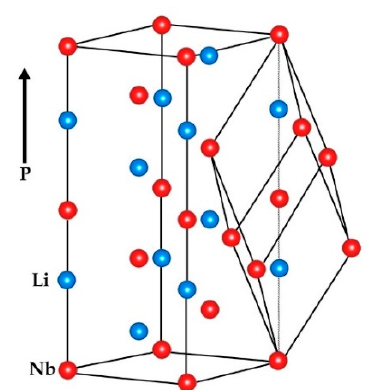
Figure 2. Conventional rhombohedral and hexagonal unit cells in LiNbO 3 , having two formula weights (10 atoms) and six formula weights (30 atoms), respectively. The oxygen atoms are omitted..